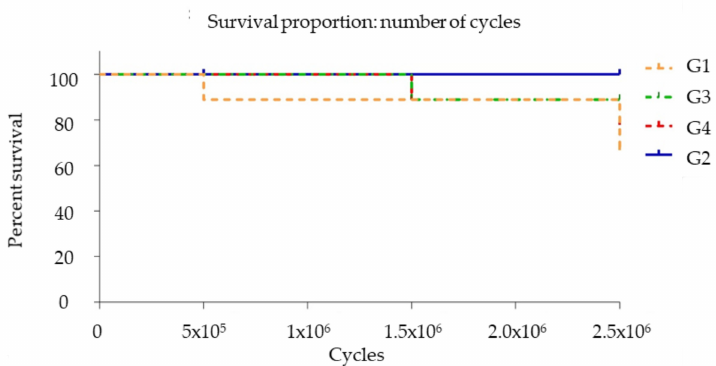
Figure 4. The Kaplan-Meier estimate curve for survival of zirconia crowns of four types of